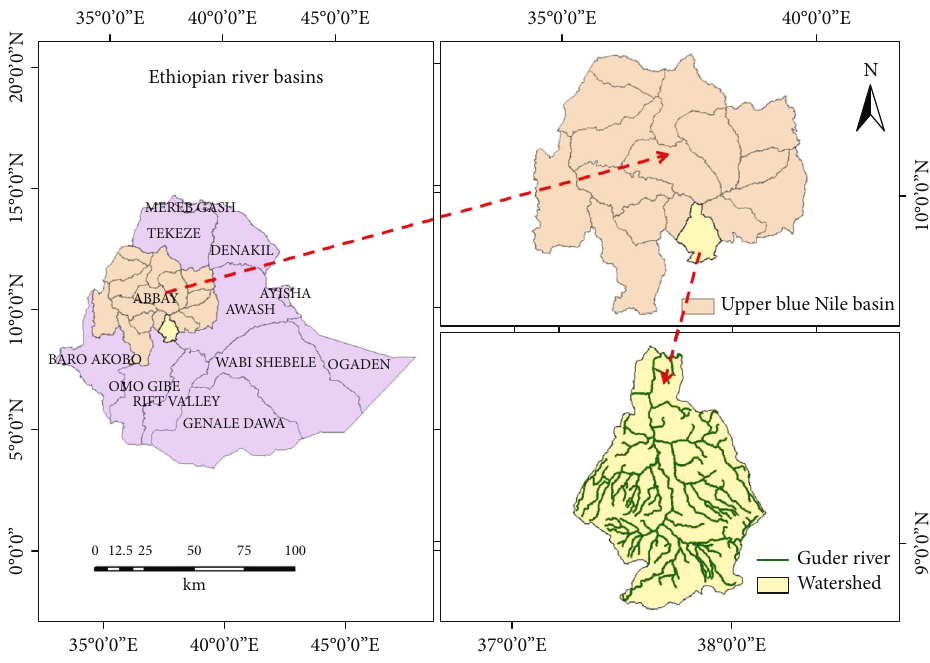
Figure 1: Guder subbasin map [25,